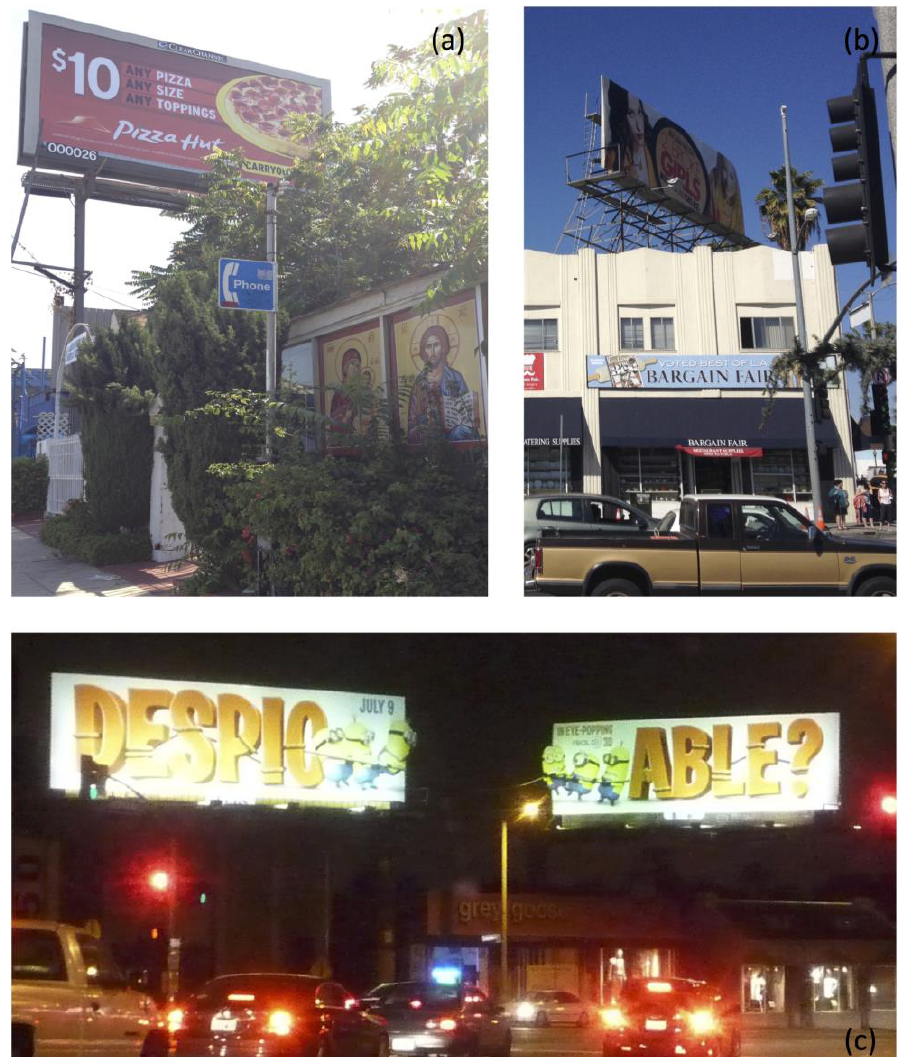
Figure 3 . Examples of types of signs and sign attributes collected by the city inventory and the Billboard Map, including (a) a double-sided pole sign; (b) a lighted roof sign; and (c) two digital pole